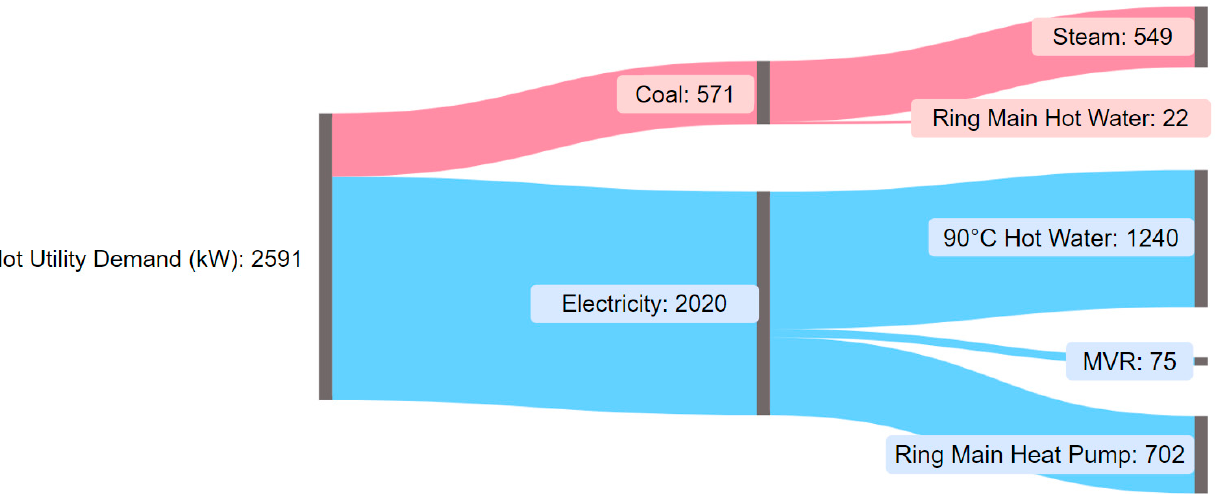
Figure 9. Sankey diagram of case study process heat sources and uses in the MW after MVR and Heat Pump